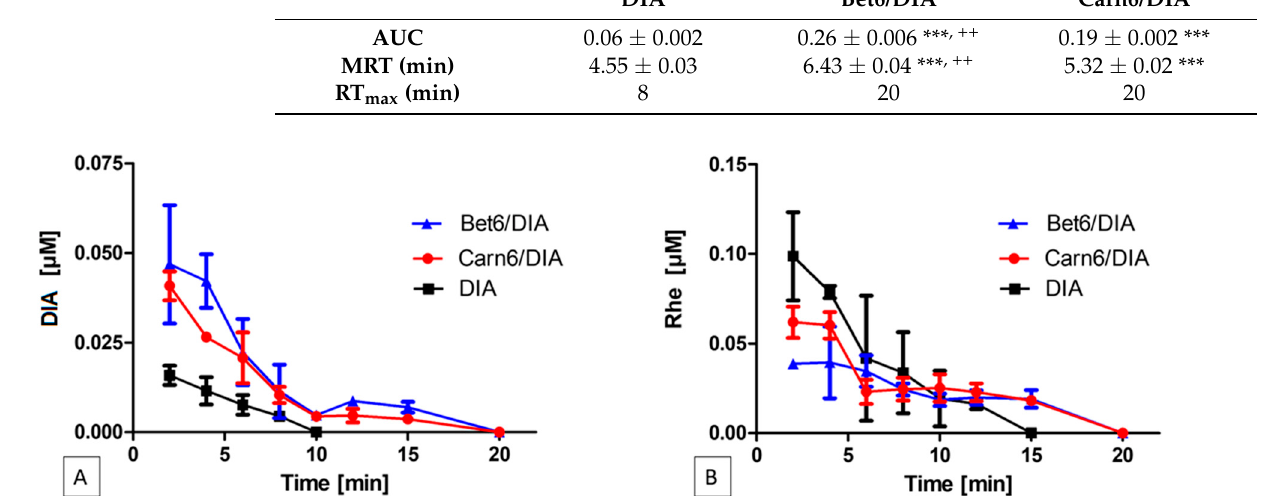
Figure 9. In vivo elimination kinetics from tear fluid assessed either ( A ) directly, by DIA monitoring, or ( B ) indirectly, by monitoring its hydrolysed active metabolite Rhe. Each point is the mean ± SD of 10